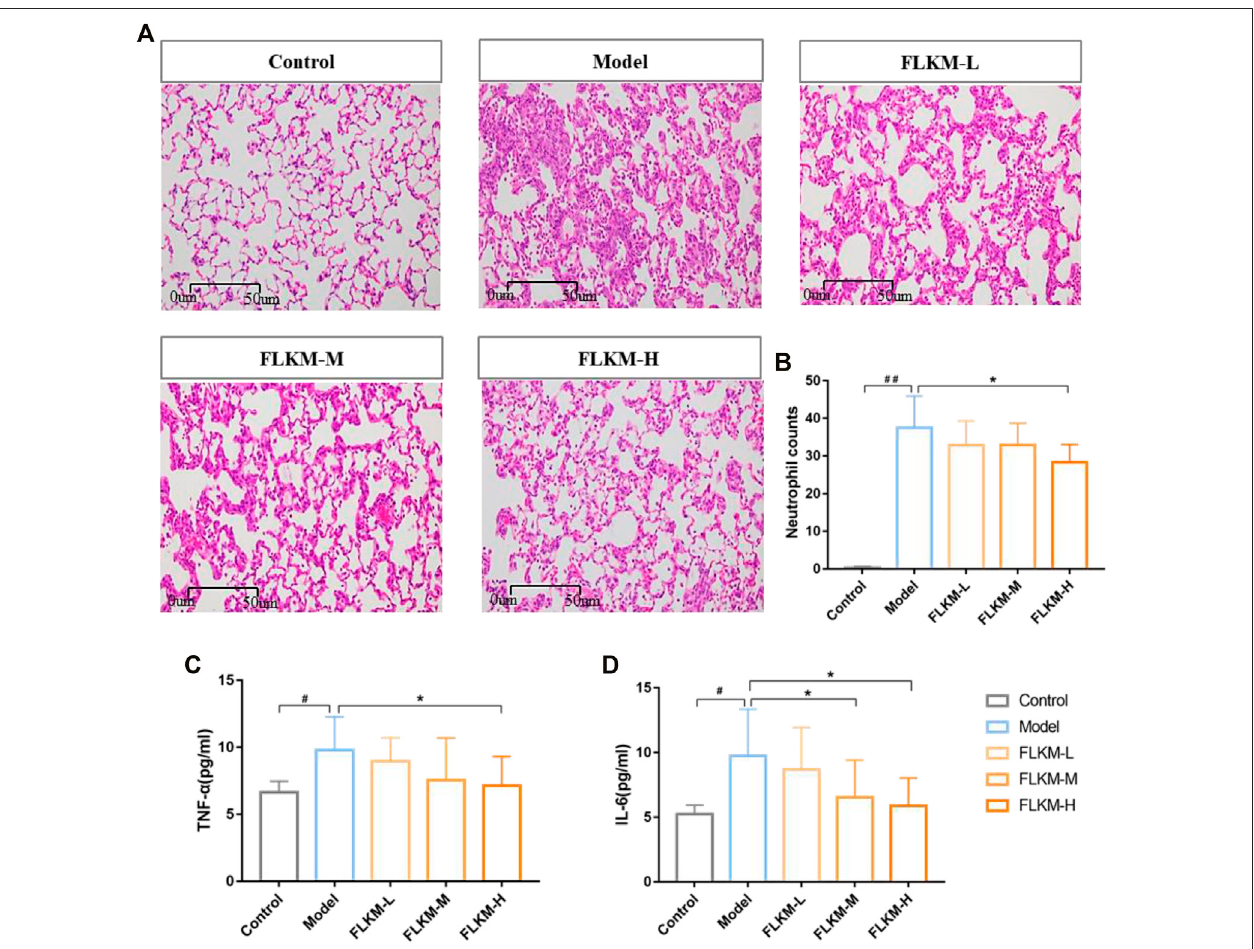
FIGURE 4 | The protective effect of FLKM in rats with LPS-induced pneumonia. (A) HE staining images of rat right lung tissues among fi ve groups (×200 magni fi cation) ( n = 3). Representative micrographs were shown. Scale bar = 50 µm. (B) Quantitative determination the count of neutrophil in lung tissue under microscope( n =5). (C,D) TheconcentrationsofTNF- α andIL-6inBALFweremeasuredbyELISA( n =6).Thedataareexpressedasthemean±SD.# p < 0.05and## p < 0.01 compared with the control group; * p < 0.05 and ** p < 0.01 compared with the model